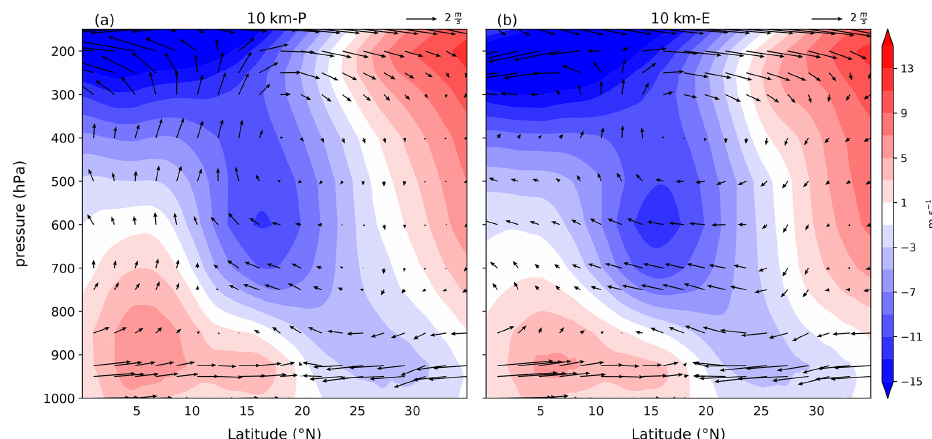
Figure A2. The same as Fig. 6 but for the 10km-P and 10km-E